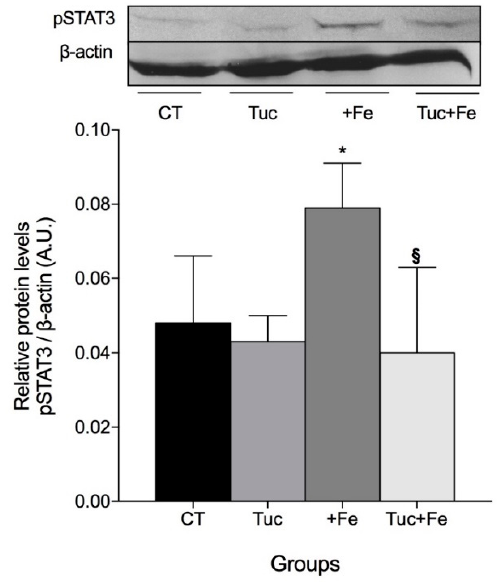
Figure 3. Hepatic mRNA level quantification of transferrin receptor ( Tfr1 )( A ) and hereditary hemochromatosis protein homolog ( Hfe )( B ) mRNA levels in rats fed control diet, tucum-do-cerrado (Tuc), iron-enriched diet (+Fe), or tucum-do-cerrado iron-enriched diet (Tuc+Fe), for 12 weeks. Data are the average ± standard deviation ( n = 6). Statistical differences compared to: * CT group; # Tuc group, and § +Fe group and ( p < 0.05). 3.4. The Effect of Tuc on the Hepatic pSTAT3 Protein Levels Another stimulus that induces hepcidin expression is by the proinflammatory cytokines, which result in an increase of STAT3 protein phosphorylation. In another set of experiments with the same rats [10] (Figure S1), we observed that Tuc, in normal and iron excess (Tuc+Fe), did not promote any change in the levels of the proinflammatory markers IL-1 β , IL-6, and TNF- α , compared with CT.